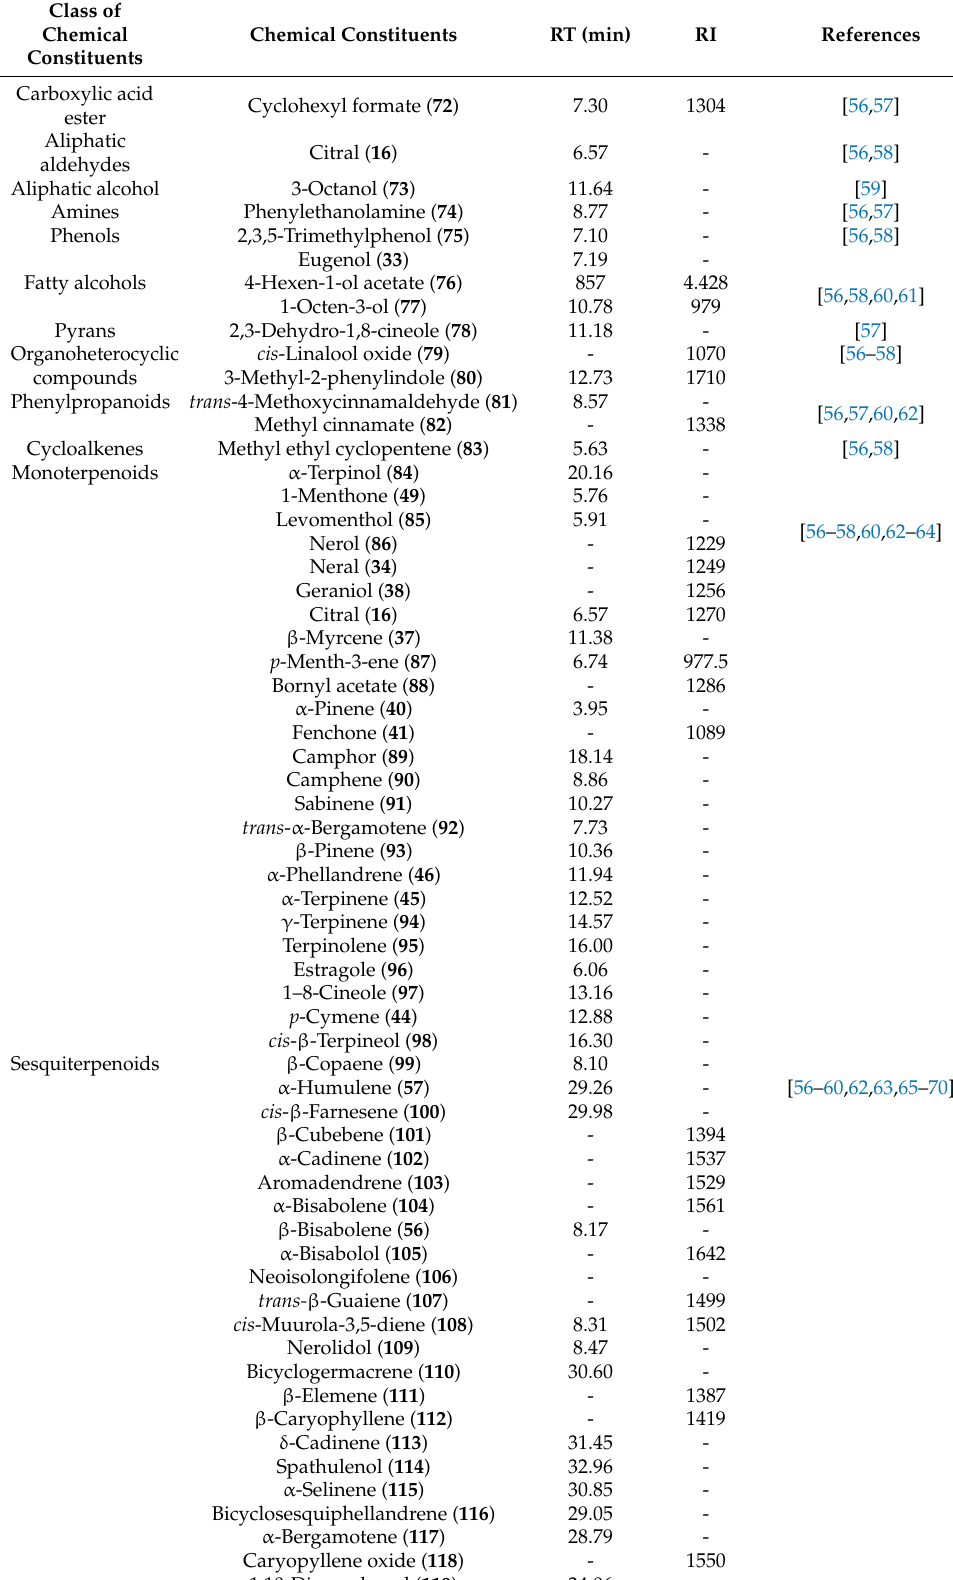
Table 2. The chemical constituents of O. basilicum